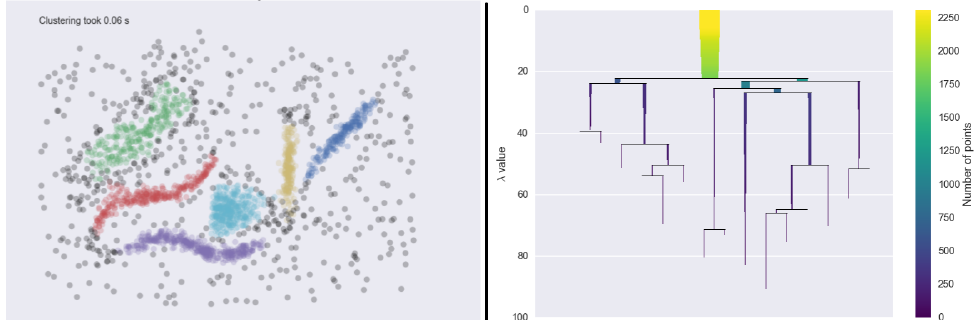
Figure 6. An example of how HDBScan works. Left image shows how clusters are formed based on the inter-points’ distance. Right image shows how clusters are arranged in a hierarchical manner as a dendrogram. Image reference from